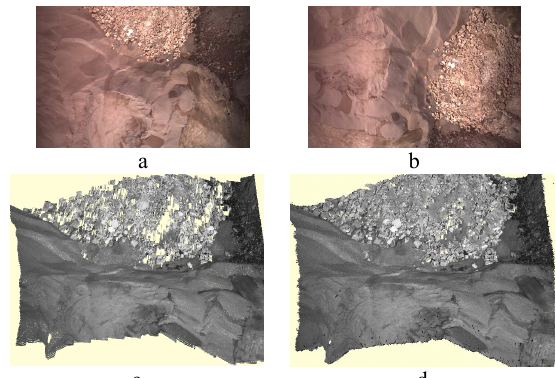
Figure 10. Example of two images (a, b) processed for dense matching using c) the proposed algorithm, d) SURE software.